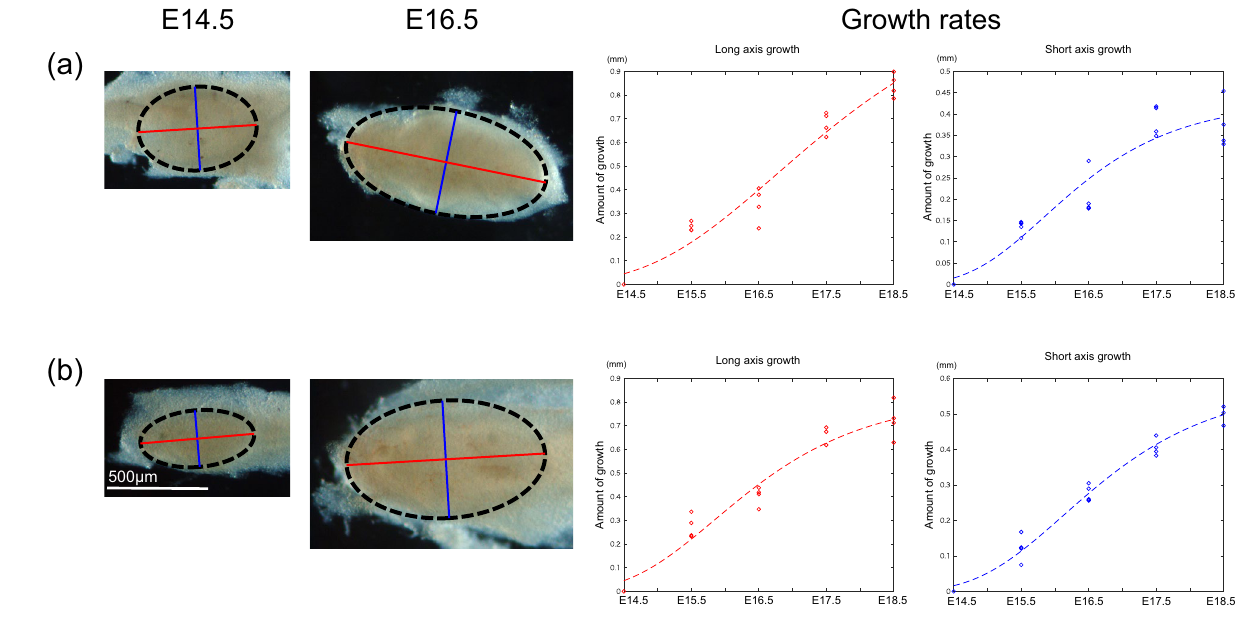
Figure 3. Modeling of molar growth. The length along the long and short axes of tooth germ is measured every other day from E14.5 to E18.5 ( n = 4 for each time point) in UMs ( a ) and LMs ( b ). The parameters for fitting growth rates are the following: UM long axis, α = 1.267; β = 3.337; γ = 0.5316 ( r 2 = 0.96). UM short axis, α = 0.4295; β = 3.342; c = 0.9023 ( r 2 = 0.91). LM long axis, α = 0.8218; β = 2.895; γ = 0.7901 ( r 2 = 0.95). LM short axis, α = 0.5811; β = 3.577; γ = 0.7851 ( r 2 = 0.98). The ellipse with the black dashed line indicates tooth germ, and red and blue lines correspond to long and short axes, respectively.